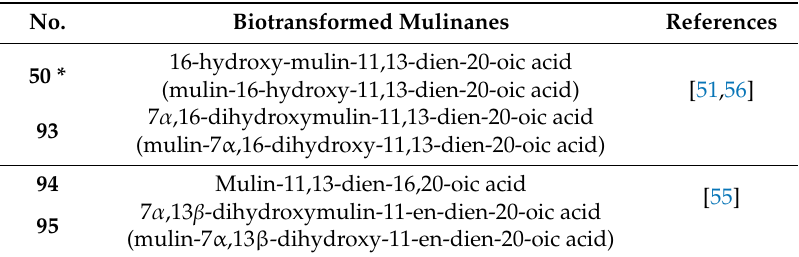
Table 4. Mulinane derivatives obtained through biotransformation.